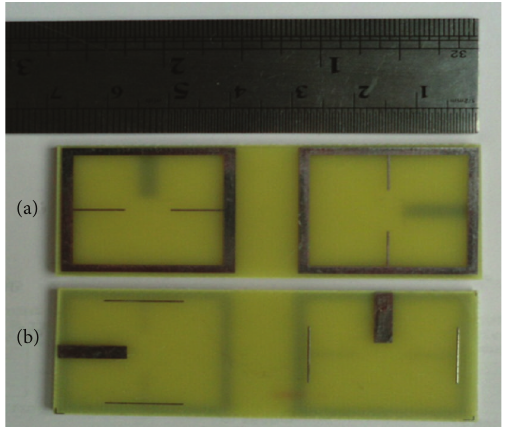
Figure 8: Prototype of fabricated MIMO antenna, (a) front view and (b) bottom view.